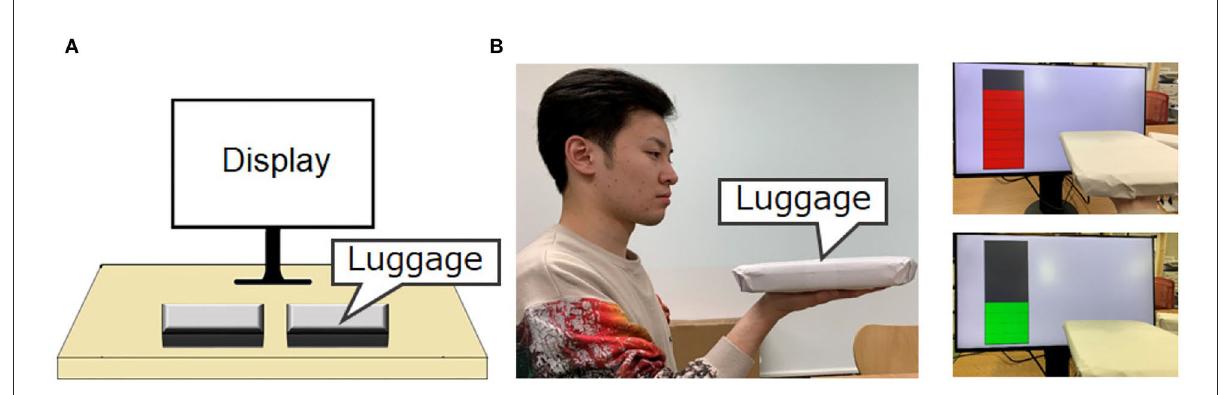
FIGURE4 (A) Placement of luggage, (B) posture when holding luggage and how to view the presented information (Futami et al.,